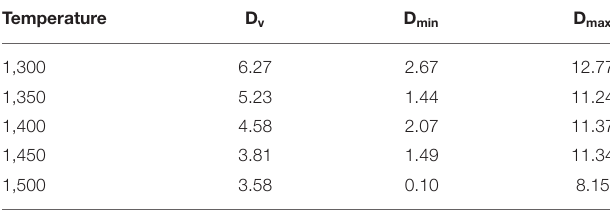
TABLE 2 | The particle size of the powders measured by SEM ( µ